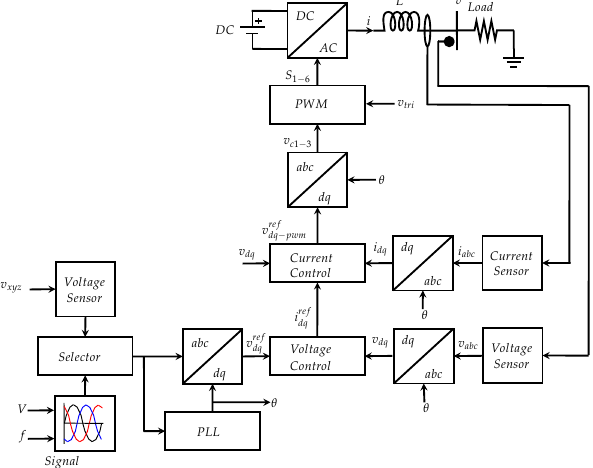
Figure 2. Grid-forming control of grid-connected